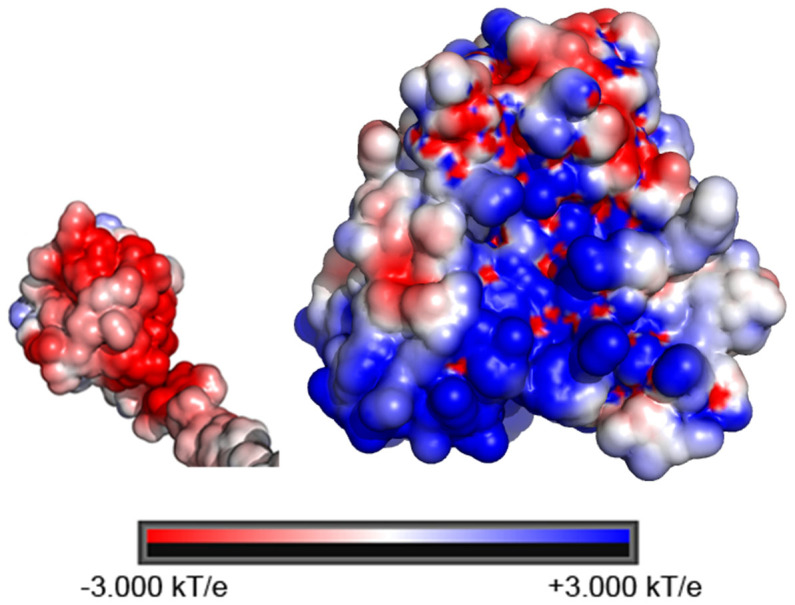
Electrostatic potential surfaces of the proximal sides of cyt b5 (left) and CYP2B4 (right), showing the negatively charged convex surface of cyt b5 (PDB code: 2M33)24 and the positively charged concave surface of CYP2B4 (PDB code: 1SUO34).The electrostatic potential surfaces were calculated using the PDB2PQR5051 server and PyMOL52 with the APBS plugin 2.153.